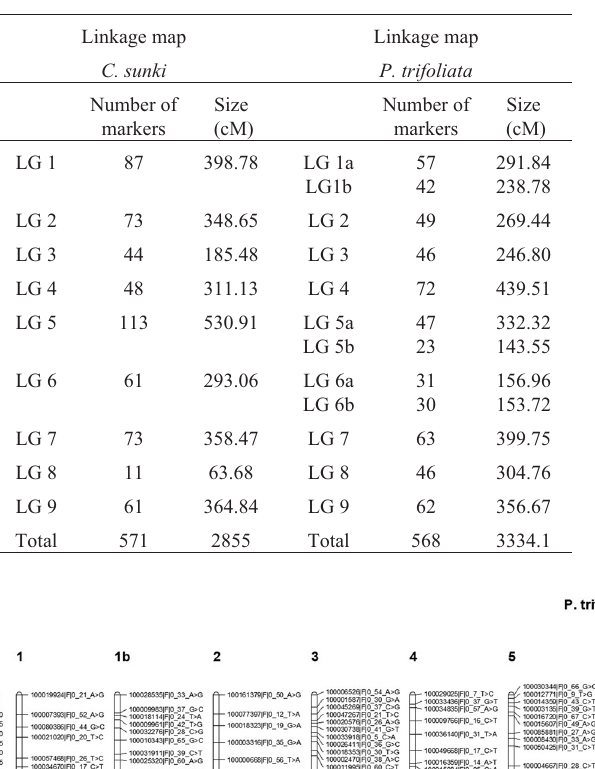
Table 1 - Distribution of mapped SNP marker numbers and sizes (cM) for each linkage group in the C. sunki and P. trifoliata linkage maps.